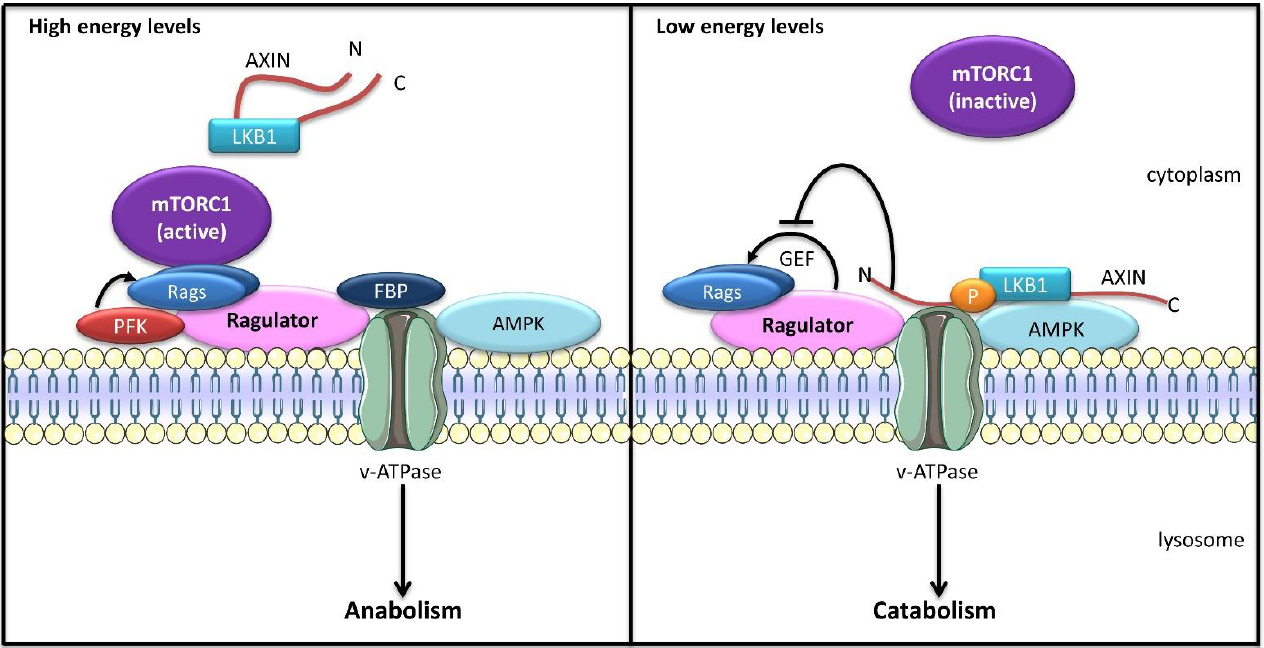
Figure 4. Glucose sensing on lysosomal membrane. In nutrient-rich conditions (high energy), high concentrations of fructose-1,6-bisphosphate (FBP) prevent the translocation of the AXIN/LKB1 complex to Ragulator and the activation of AMPK. Furthermore, the glycolytic enzymes phosphofructokinase 1/2 (PFK) interact with RagB, promoting mTORC1 activation on lysosomal membrane and turning on cell anabolism. In starved cells (low energy), with low FBP levels, lysosomal Ragulator acts as a docking site for the AXIN/LKB1 complex, allowing LKB1-mediated phosphorylation of AMPK and its activation. The recruitment of AXIN to Ragulator inhibits the latter’s GEF activity towards Rags, releasing mTORC1 from lysosomal membrane, thus suppressing its pro-anabolic activity.